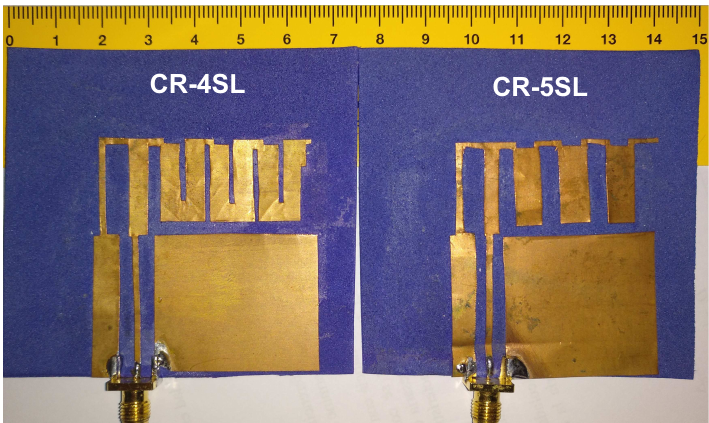
Figure 8. Final prototypes of the modified MS-IFA over the textile substrate constructed. On the left, the one obtained with the CRO-4SL. On the right, the one obtained with the